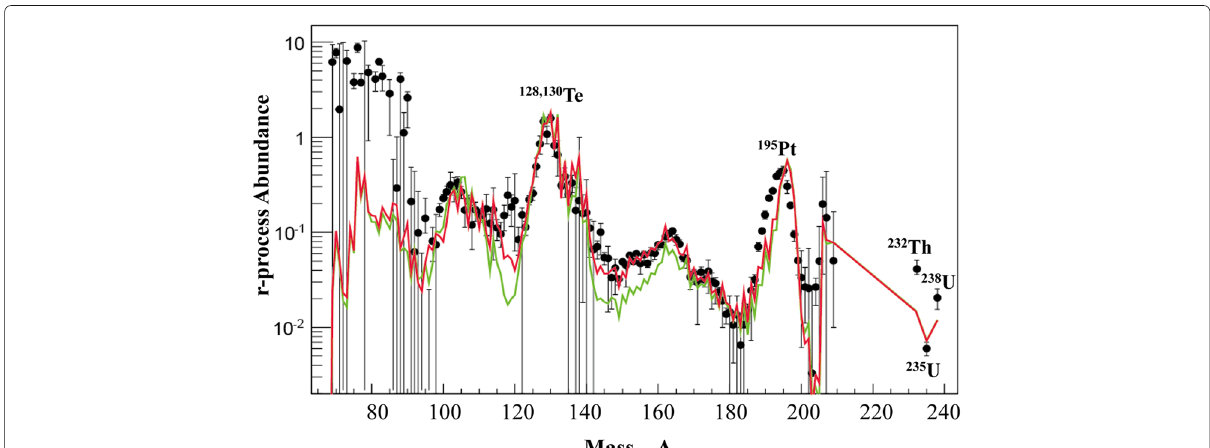
Fig. 6 A comparison between the estimated r-process abundance curves with (red) and without (green) taking account of the new experimental data from RIBF [10]. Theoretical abundances are calculated in a canonical SN nucleosynthesis model assuming (n, γ ) - ( γ ,n) equilibrium [224]